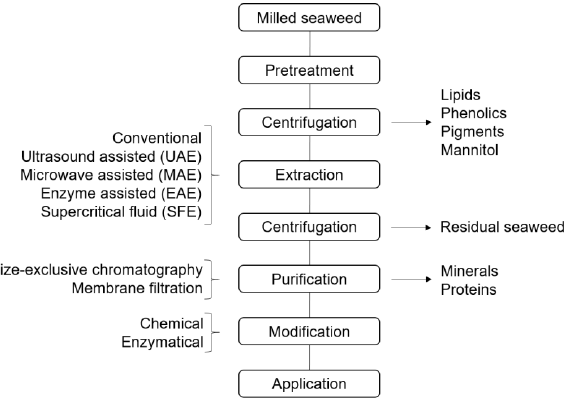
Figure 1. Basic flow chart of extraction of polysaccharides from brown macroalgae.